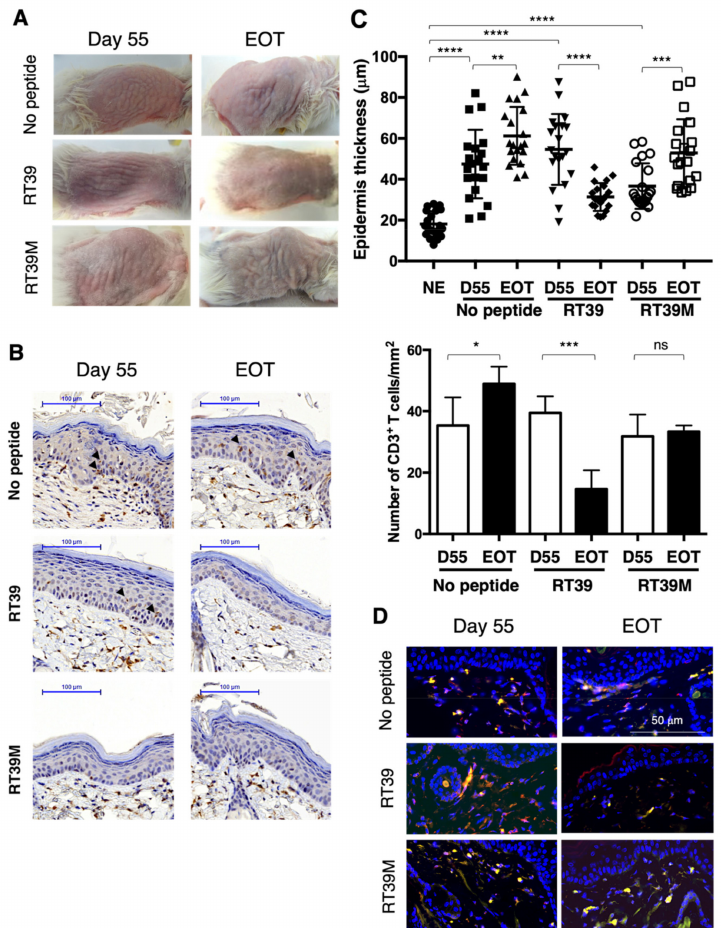
Figure 2. In vivo validation of RT39 peptide anti-tumor efficiency. After engraftment and appearance of cutaneous manifestations (55 days post-injection), mice were randomly separated in 3 groups ( n = 5 each) and either left untreated (no peptide) or treated with RT39 or RT39M peptide. Skin biopsies were collected before (Day 55) and at the end of treatment (EOT). ( A ) Visual evaluation of cutaneous disorders before and after peptide treatment. Shown are pictures of one representative mouse from each group. ( B ) Immunohistochemical analysis of skin sections. Labeling was performed using an anti-human CD3 mAb, allowing observation of the epidermis thickness and of epidermal (arrowheads) and dermal T cell infiltrates. Shown are representative data obtained on one representa- tive mouse from each group. ( C ) After CD3 staining, epidermis thickness was measured (7 points of measurement; upper panel) and CD3 + T cells were enumerated (bottom panel) on skin sections corresponding to 3 mice in each group. Similar analysis was realized on control/not engrafted mice (NE; n = 3). Statistical analysis was performed using a Mann–Whitney t test. * p < 0.05, ** p < 0.01, *** p < 0.001, **** p < 0.0001, ns: not significant. ( D ) Analysis of the presence of the malignant T cell clone by immunofluorescence using human CD3 and KIR3DL2 as tumor T cell marker. Shown are representative data obtained on one mouse from each